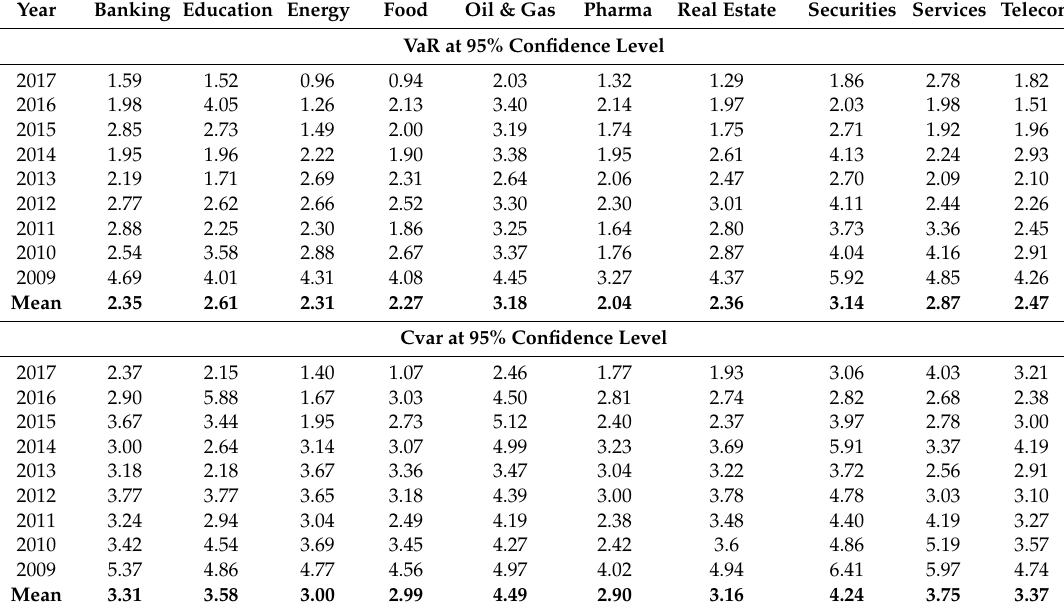
Table 1. VaR and CVaR at 95% confidence by year,